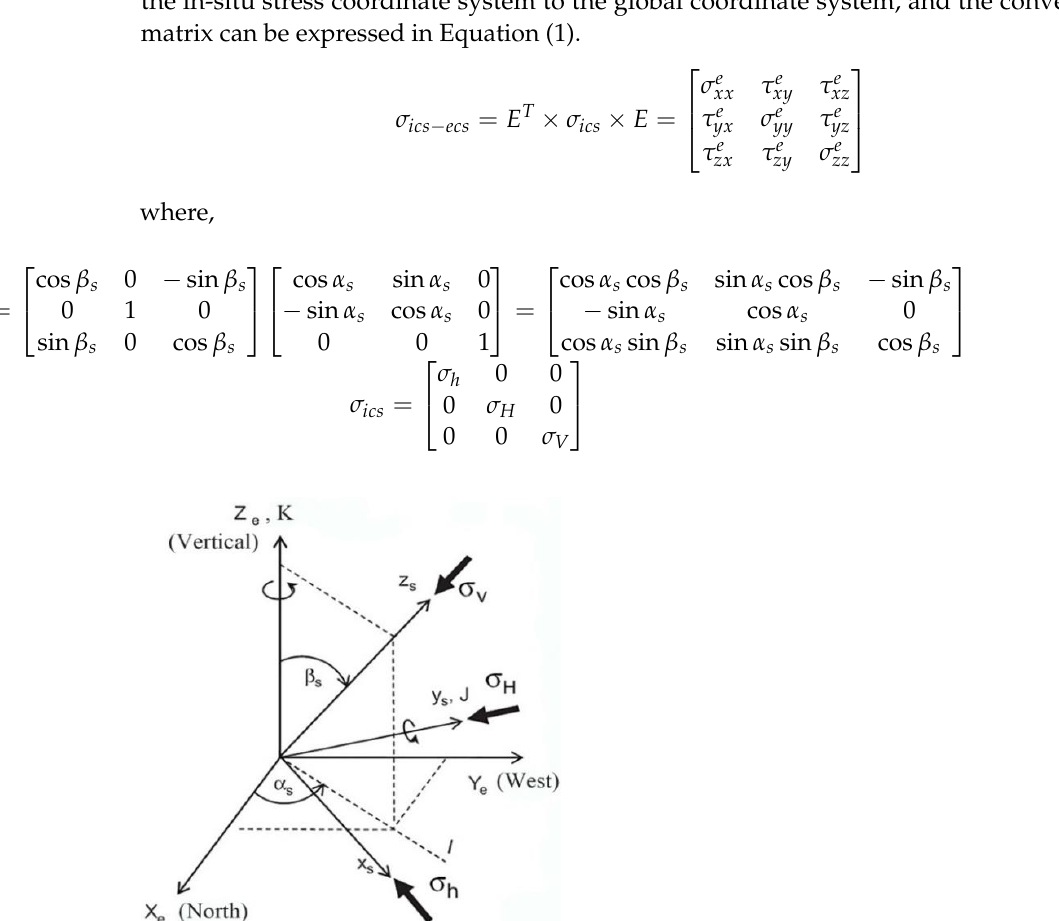
Z b indicates the direction of the well bore axial, Y b indicates the direction of the lateral